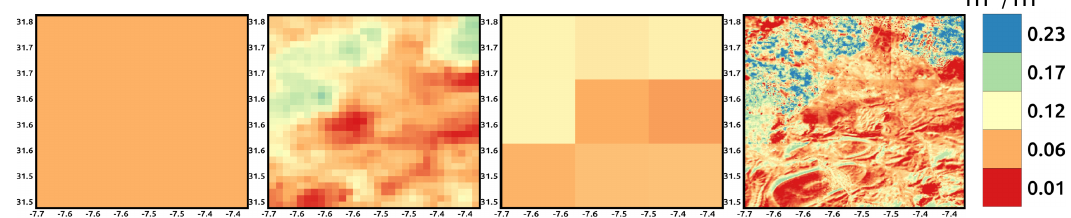
Figure 10. From left to right: images of 36 km resolution SMAP SM, 1 km resolution DISPATCH Exp SM, 10 km resolution aggregated DISPATCH Exp SM and 100 m resolution disaggregated SM on DOY